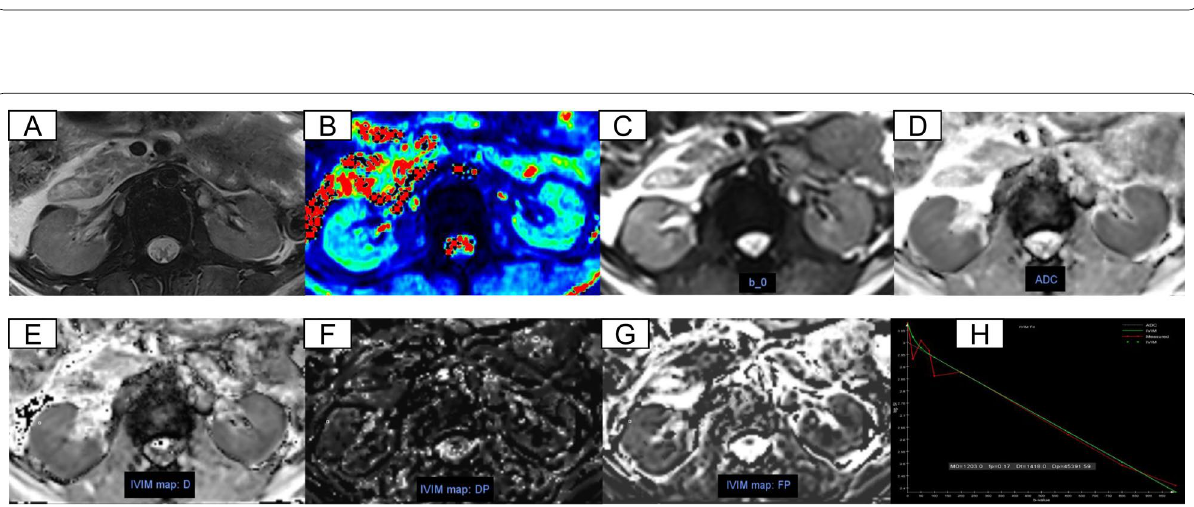
Fig. 3 Respective MRI images of CKD stage 1–3 (7 years old, male). A – H Axial T2-weighted images, T2* mapping, b0 map, ADC, D t , D p , f p , IVIM fit, respectively